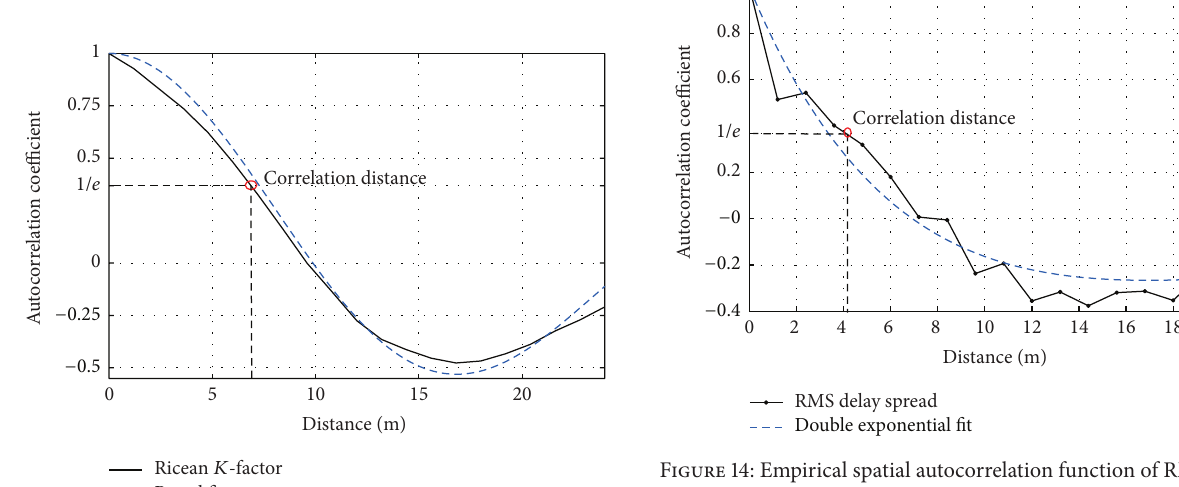
Figure 12: Empirical spatial autocorrelation function of large-scale fading with an exponential fit.